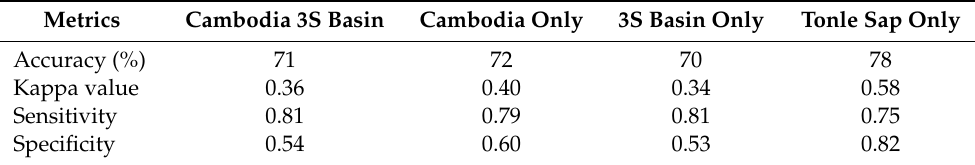
Table 3. Validation statistics for statistical predictive models of drivers of forest loss.